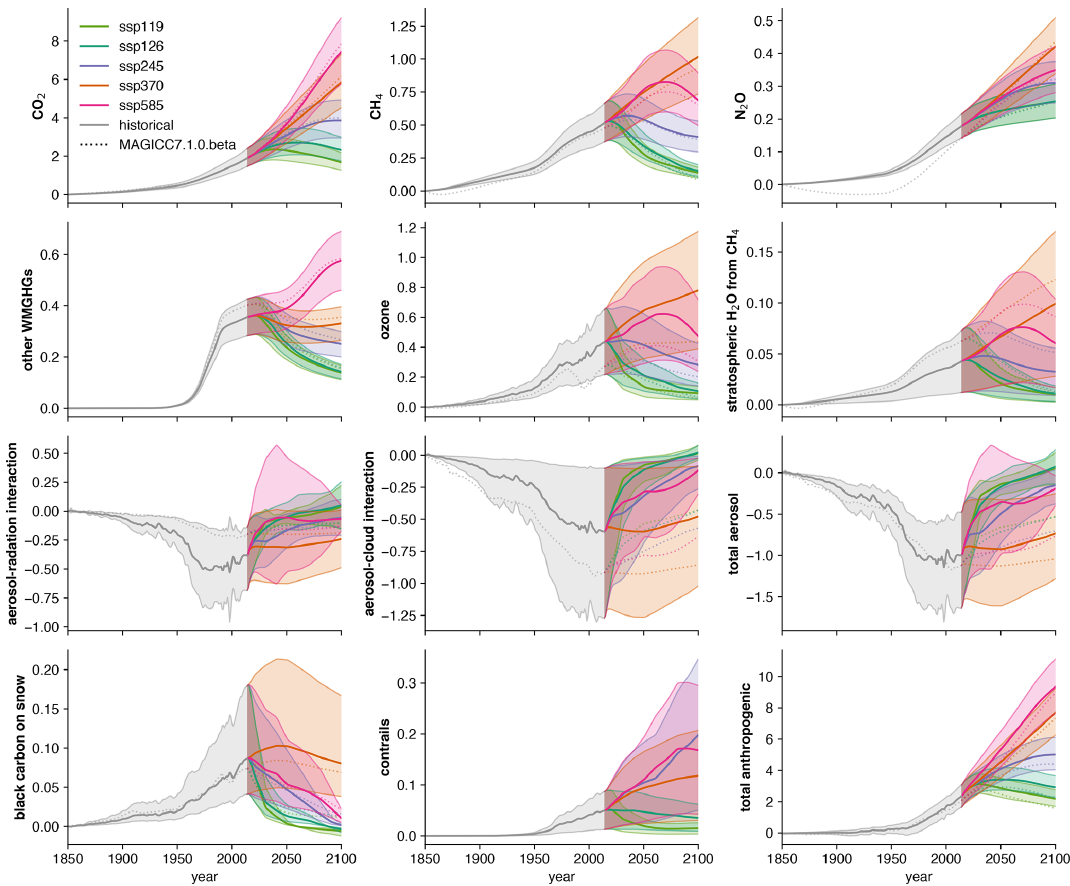
Figure 9. ERF time series (in Wm − 2 ) by category for a range of SSP pathways using the FaIRv2.0.0-alpha constrained ensemble. Solid lines indicate central estimate, and shading shows the 5%–95% range. Dashed lines show default projections from MAGICC7.1.0-beta from RCMIP (Nicholls et al.,